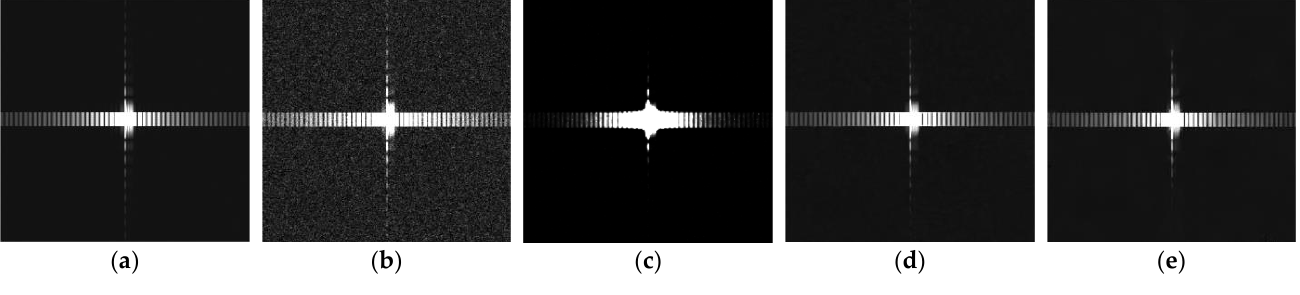
Figure 3. Filtering results for the “building” image. ( a ) The clean image. ( b ) The single-look speckled image. ( c – e ) are, respectively, the SRAD, PPB and SAR-BM3D filtered image.